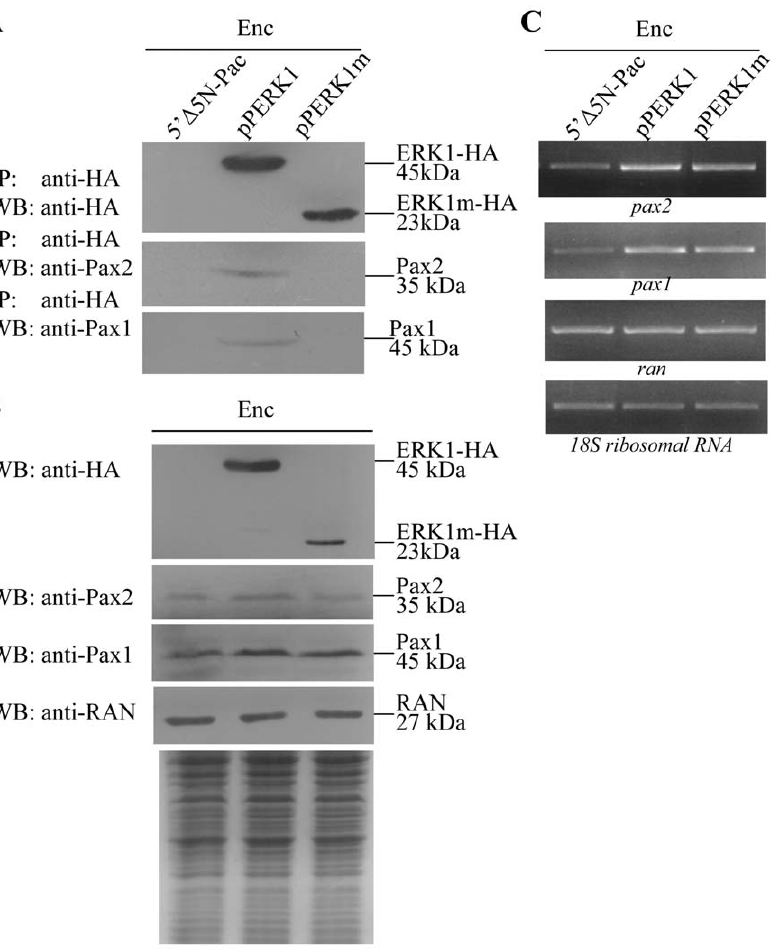
Figure 11. Interaction between ERK1 and Pax2 (or Pax1). (A) Co-immunoprecipitation assay. The 5 9 D 5N-Pac, pPERK1, and pPERK1m stable transfectants were cultured in encystation medium for 24 h. Proteins from cell lysates were immunoprecipitated using anti-HA antibody conjugated to beads. The precipitates were analyzed by Western blot with anti-HA, anti-Pax2, or anti-Pax1 antibody as indicated. (B) Expression of HA tagged ERK1, Pax2, and Pax1 proteins in whole cell extracts. The 5 9 D 5N-Pac, pPERK1, and pPERK1m stable transfectants were cultured in encystation medium for 24 h (Enc, encystation) and then subjected to Western blot analysis. The blot was probed by anti-HA, anti-Pax2, anti-Pax1, and anti-RAN antibody. Equal amounts of protein loading were confirmed by SDS-PAGE and Coomassie blue staining. (C) RT-PCR analysis of gene expression in the ERK1- and ERK1m-overexpressing cell line. The 5 9 D 5N-Pac, pPERK1, and pPERK1m stable transfectants were cultured in encystation medium for 24 h (Enc, encystation) and then subjected to RT-PCR analysis. PCR was performed using primers specific for pax2 , pax1 , ran , and 18S ribosomal RNA